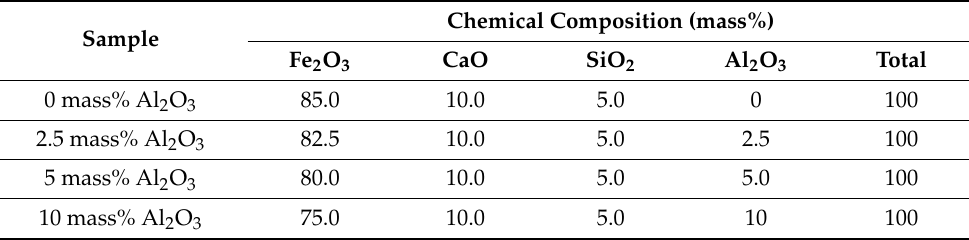
Table 1. Chemical compositions of the equilibrium and metastable samples with various Al 2 O 3